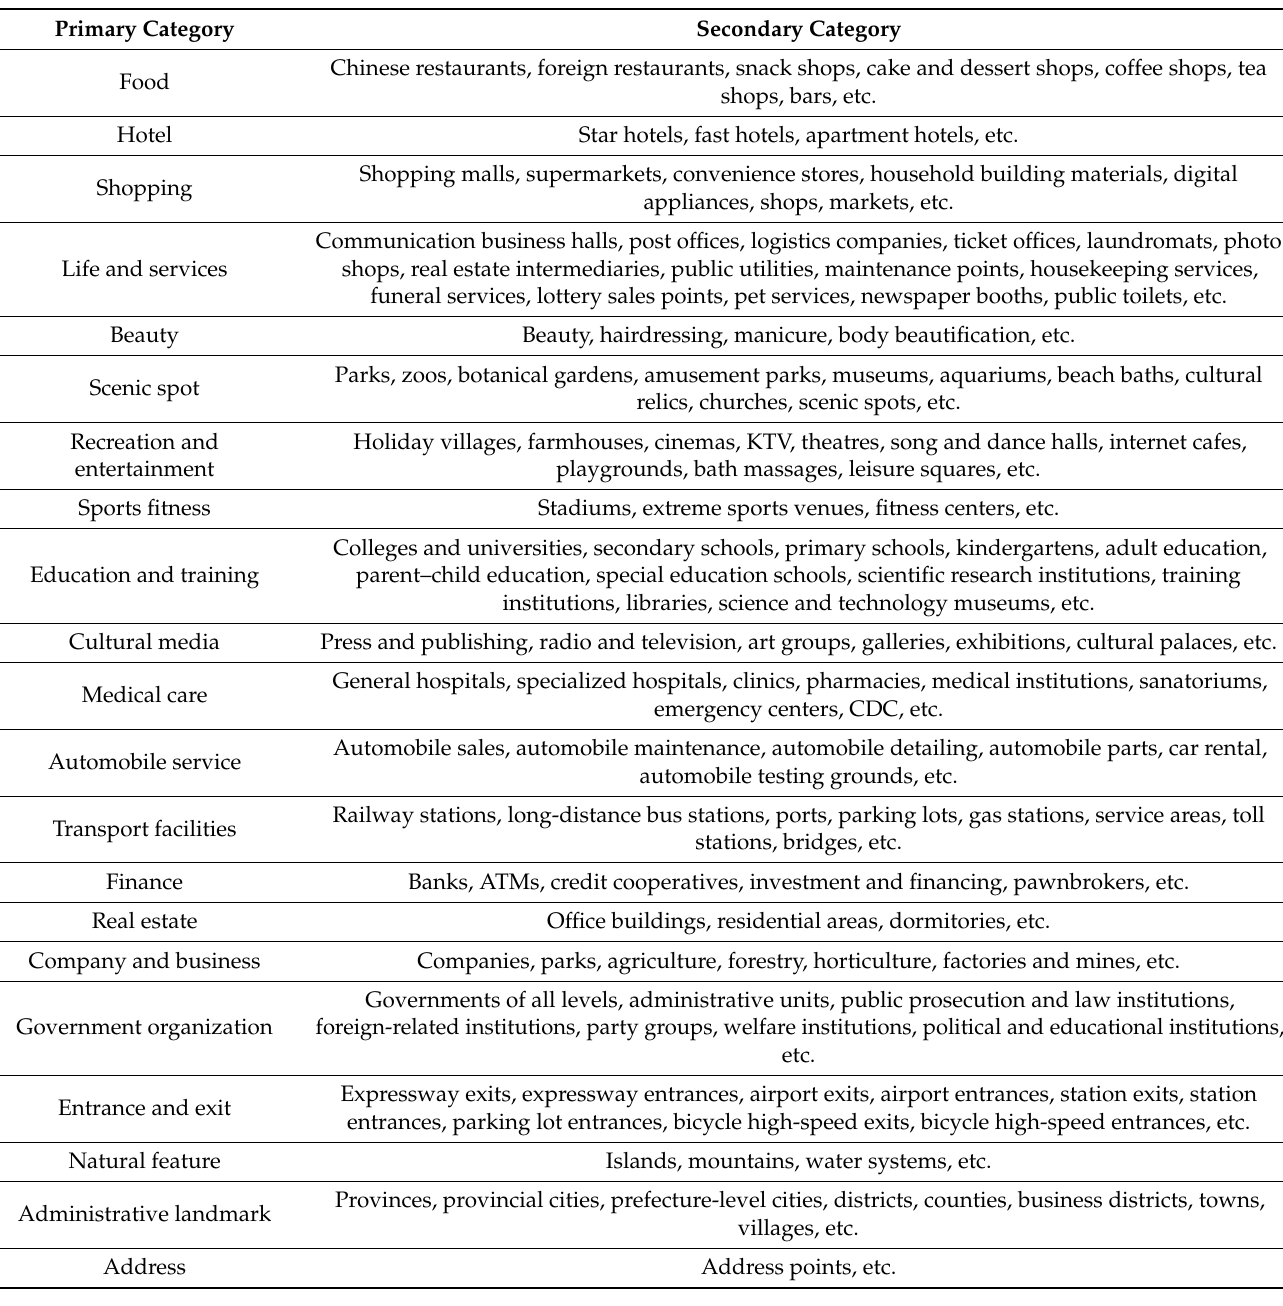
Table 1. The POI data and categories of Baidu